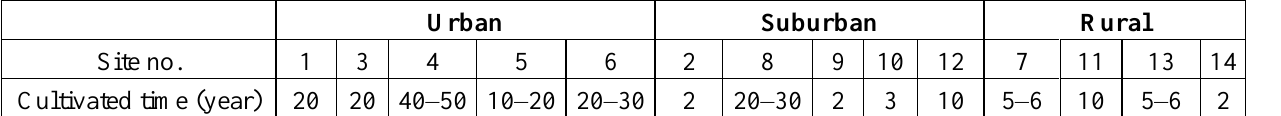
Table 3. Vegetable farming period in different